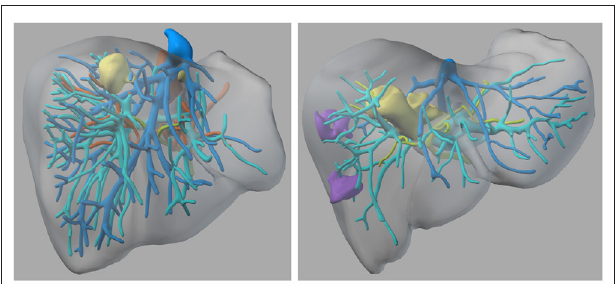
FIGURE 1 | The 3D models of the two liver cases—left: Case 1; right: Case 2—Color coding: yellow = tumor tissue, blue and cyan = veins, green = biliary tracts, orange = arteries, purple = suspected